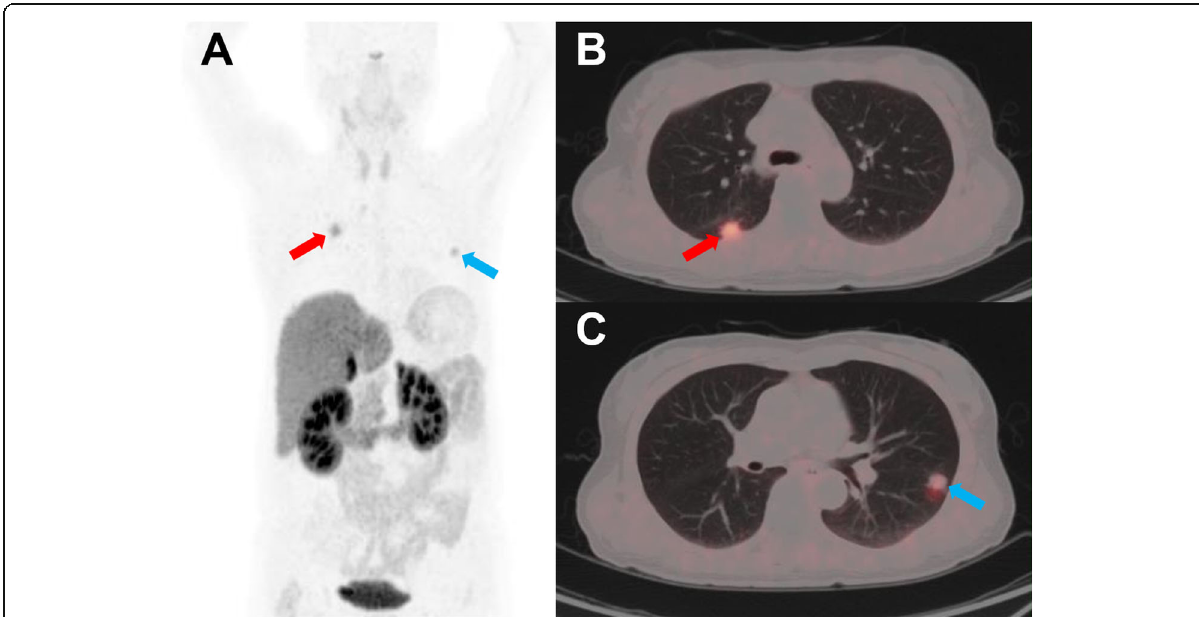
Fig. 5 Representative case of a 55-year-old male with a previous primary pancreatic NET grade 2. The patient underwent surgery for the primary pancreatic NET 8 years prior, and multiple lung nodules were found in a follow-up chest CT image. MIP ( a ) and trans-axial ( b , c ) [ 68 Ga]Ga-DOTA- TOC PET/CT images demonstrate small metastases with moderate uptake (red and blue arrows) in both lungs. His low TLR (0.98) and low SUVmax (5.85) predicted a poor prognosis; however, his good ECOG performance status (0) and low WTV (0.0) predicted a good prognosis. After lanreotide therapy, disease progression (metastatic nodule) was found in the right lower pulmonary lobe (red arrow; long-diameter increased from 1.2 to 1.7 cm) after 3 months of